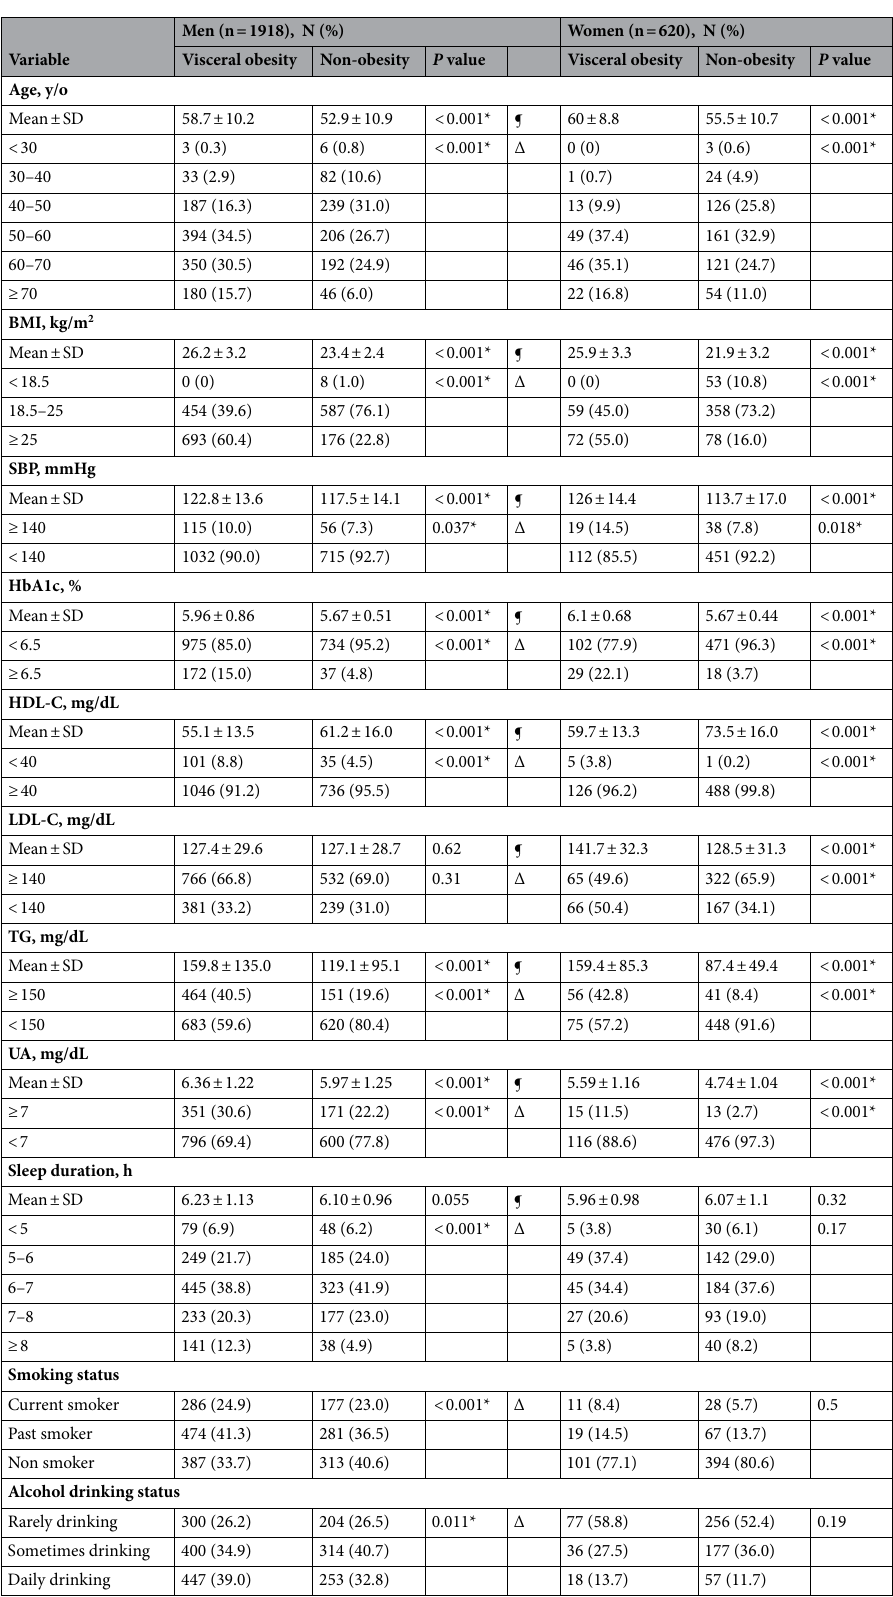
Table 2. Univariate analysis of background factors contributing to visceral obesity. *Statistically significant p-values, ¶ Mann–Whitney U test, ∆ Pearson chi-square